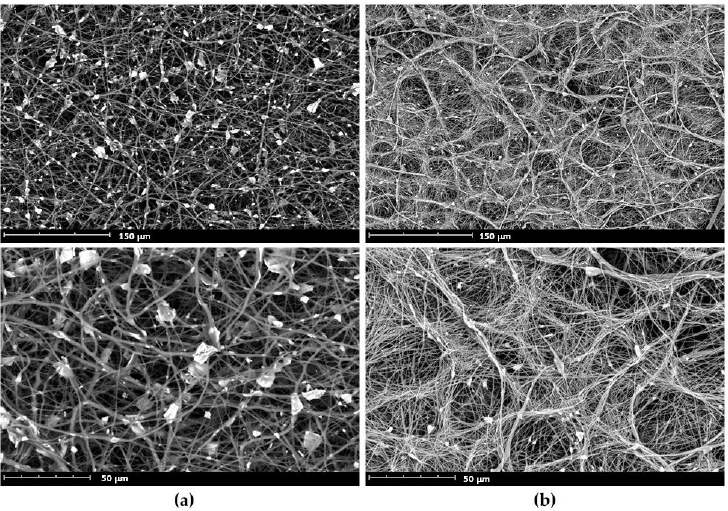
Figure 6. SEM images of PCL/HAp composite ES fibers, prepared ( a ) without PCL- b -poly( t BuOEP) (Table 1, Entry C3 ) and ( b ) in the presence of 5 wt.% PCL- b -poly( t BuOEP) (Table 1, Entry C6 ).